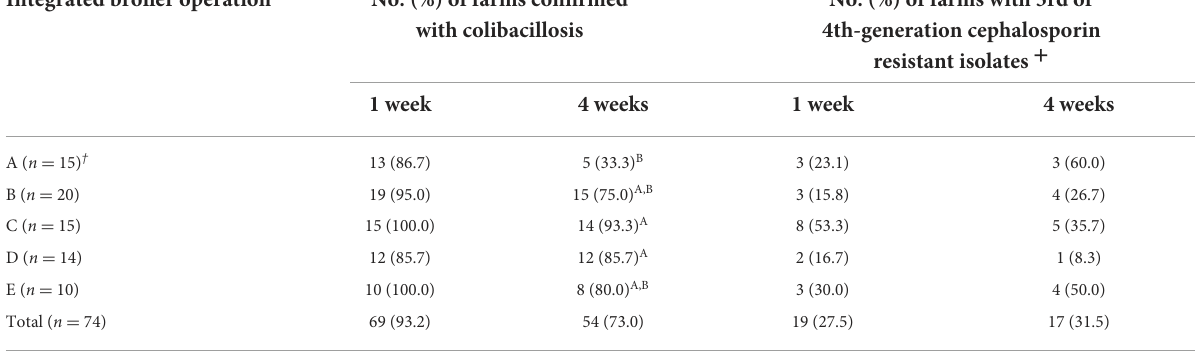
Values with different superscript letters represent significant differences among five integrated broiler operations, and significant difference of farms with 3rd and 4th-generation cephalosporinresistantisolateswasabsentbetweenoneweekandfourweeksoldbroilers( p < 0.05). †